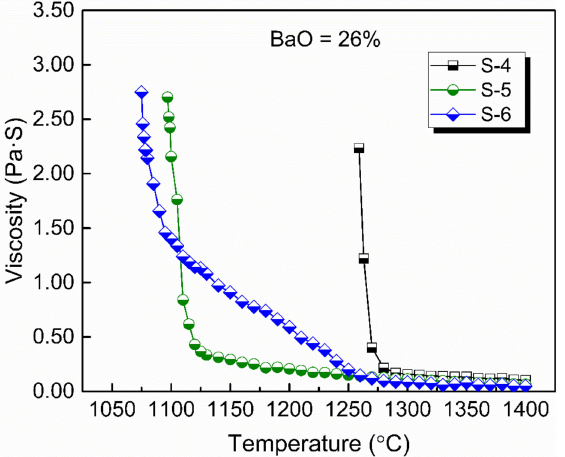
Figure 4. Viscosity–temperature curves of experimental slags with 26 wt % BaO and various CaO/Al 2 O 3 ratios.